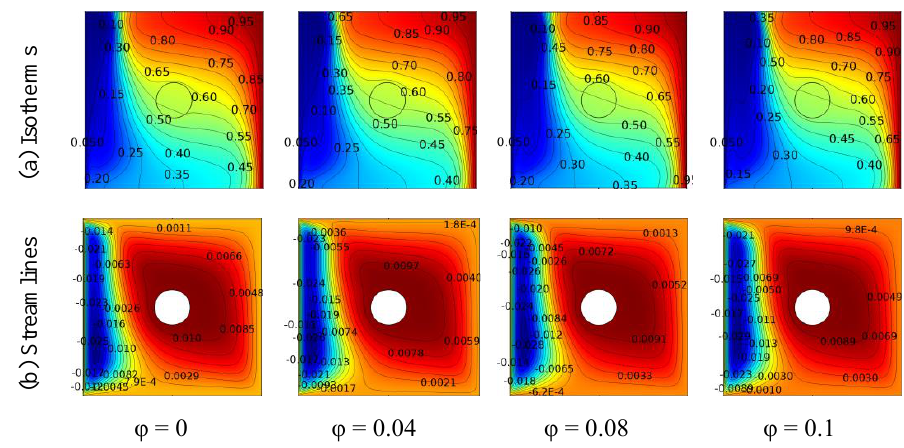
Fig. 8. isotherms (a) and Streamlines(b) for different values of φ,with Ha = 25, Ri =3.